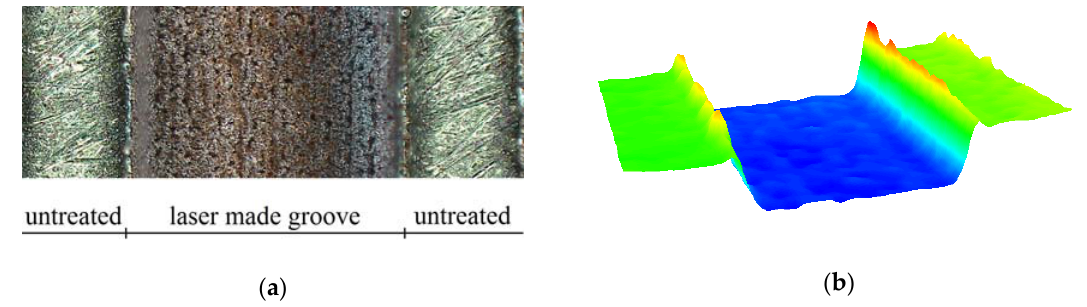
Figure 2. Images of the groove of sample no 5 (from Hirox optical microscope), magnification 140 × : 2D image ( a ), 3D image in pseudo color ( b ).